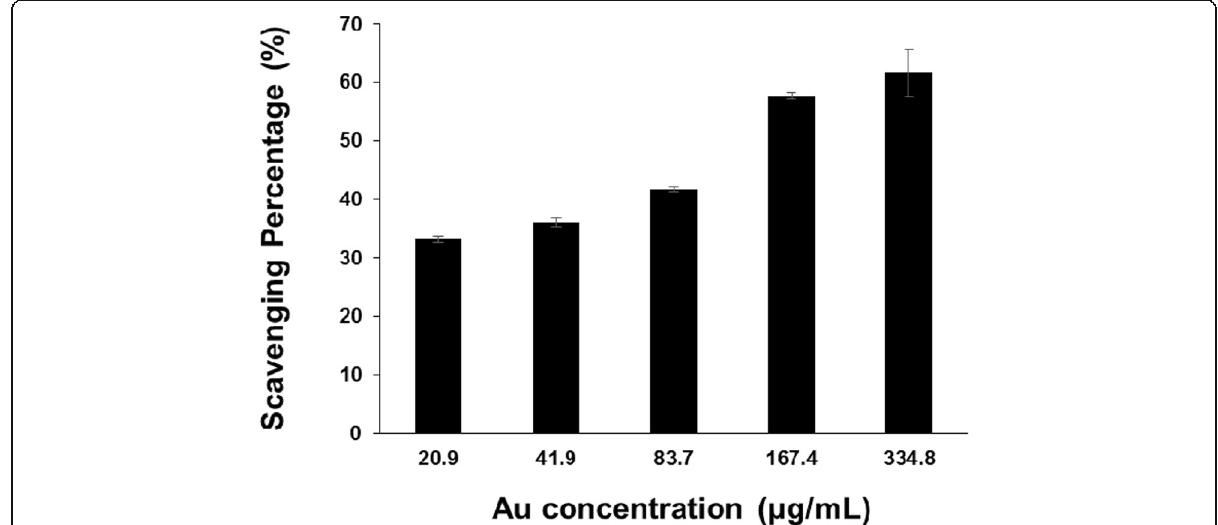
Fig. 8 DPPH radical scavenging activity of PV-AuNPs. The concentration was expressed as Au